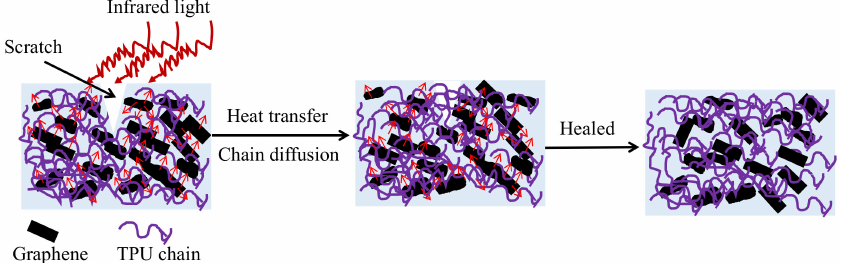
Figure 13. Schematic diagram of self-healing of the composite film under near-IR